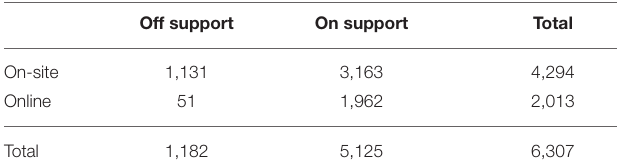
TABLE 4 | The common support for domain hypothesis testing under propensity score matching.